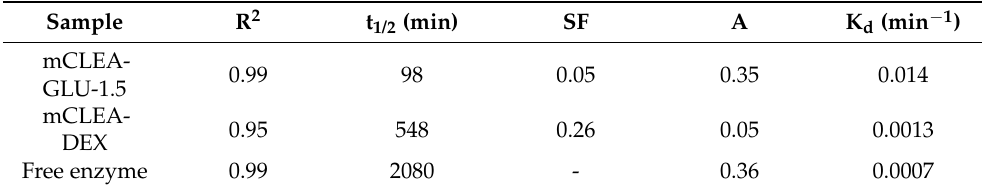
Table 7. Sadana and Henley model parameters for thermal inactivation at 50 ◦ C of free enzyme and magnetic β -galactosidase CLEA biocatalysts produced with glutaraldehyde and dextran-aldehyde.